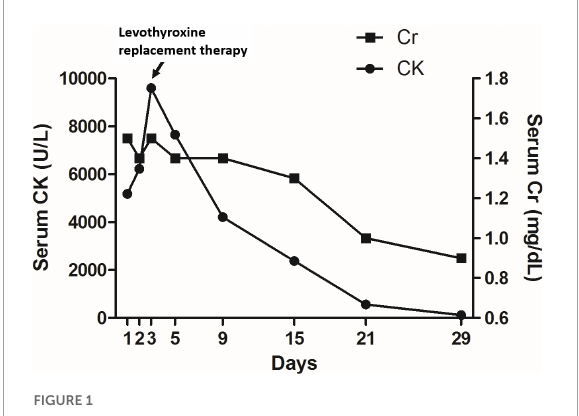
FIGURE1 Changes in serum CK levels and renal function after presentation. CK, creatine kinase; Cr,